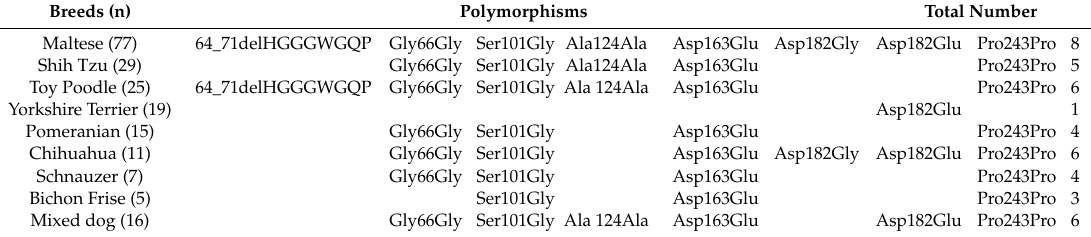
Table 4. Di ff erent distributions of PRNP polymorphisms in 8 dog